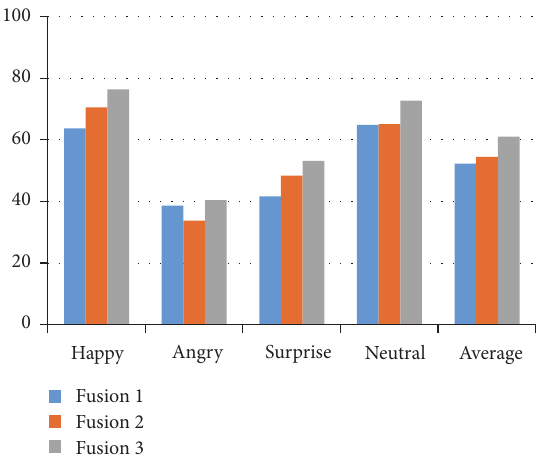
Figure 10: Recognition rates of 3 fusion